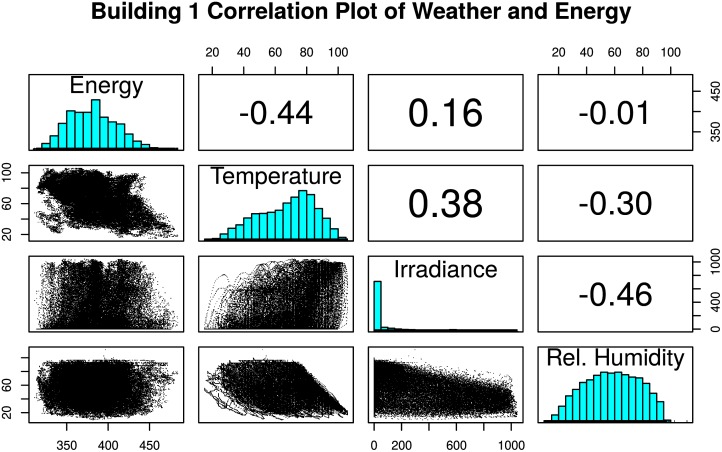
Correlations of electricity consumption and weather.Correlation plot of weather data and energy for Building 1.